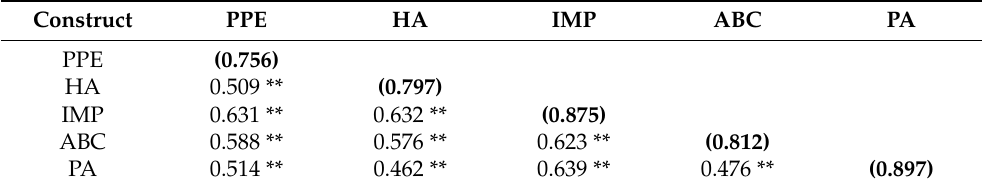
Table 3. Discriminant validity